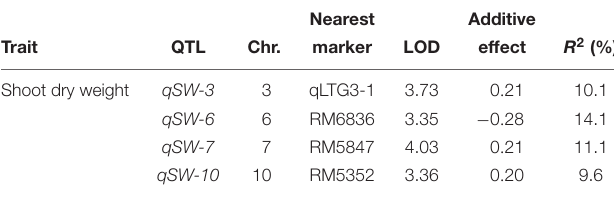
TABLE 1 | QTLs for shoot dry weight per plant detected in the